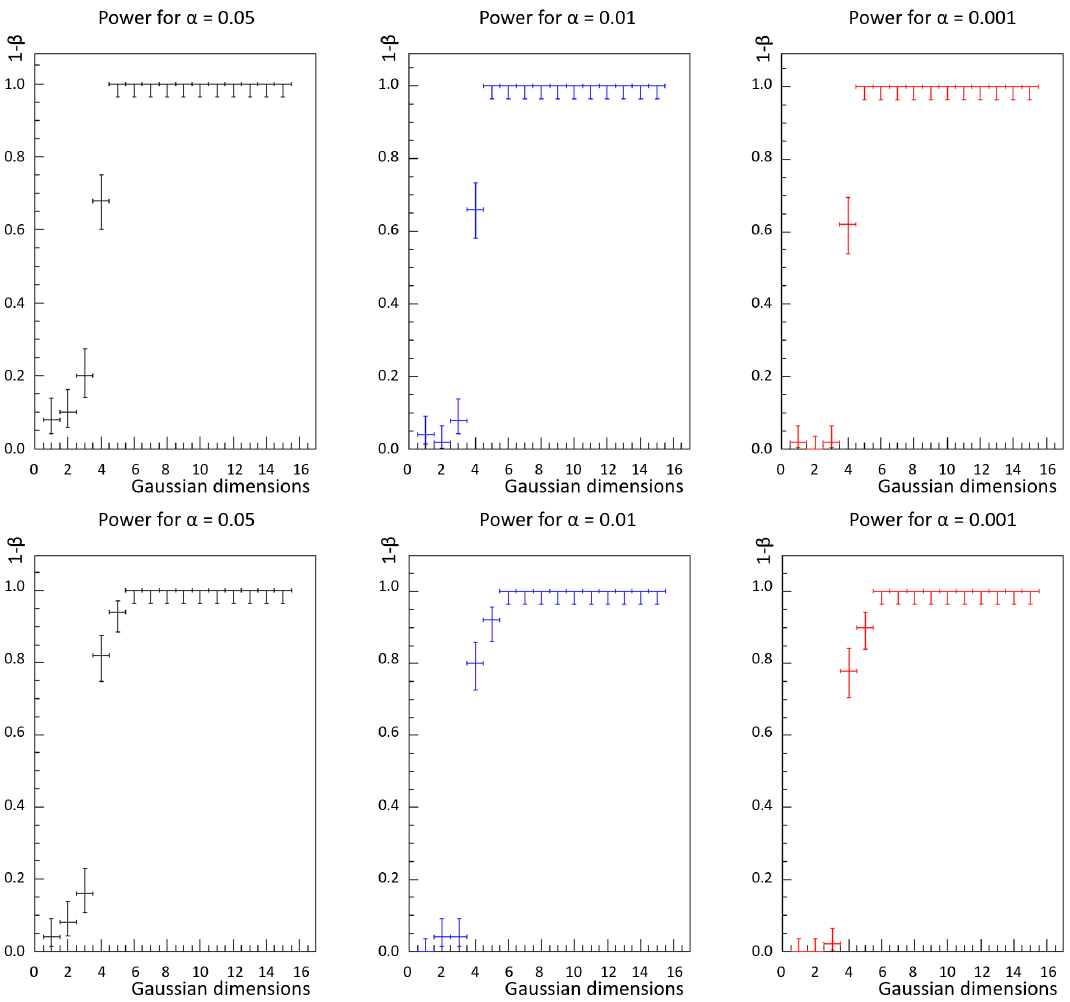
Figure 8 . RanBox (top) and RanBoxIter (bottom) power curves for Z PL as a function of the number of Gaussian features in signal events, in samples containing 50 signal events and 4950 flat-distributed events. The black points correspond to α = 0 . 05 , the green points to α = 0 . 01 , and the red points to α = 0 . 001 ; the latter two are obtained from extrapolated values of the critical region. 68 . 3% intervals are computed with the Clopper-Pearson method for the Binomial ratio. See the text for more